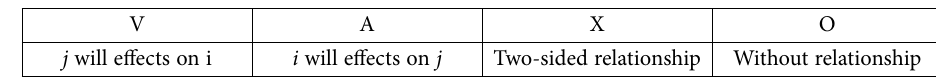
Table 10. Symbols for ISM